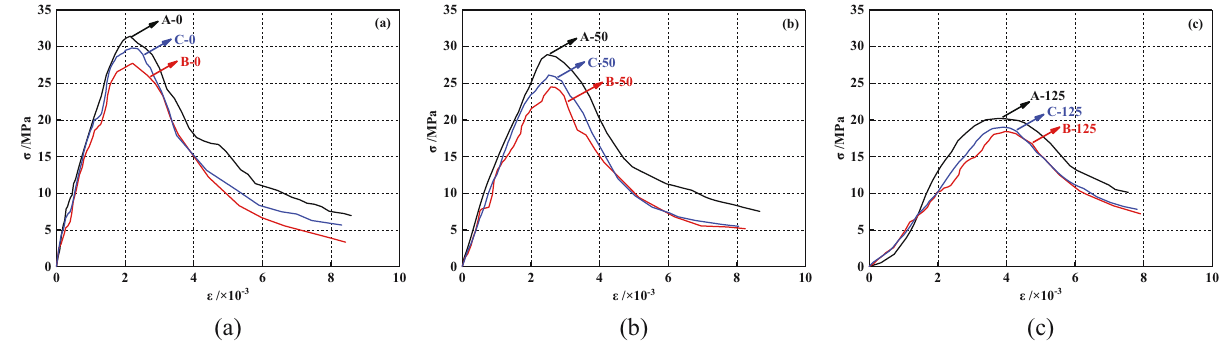
Figure 13: Comparison of stress – strain curves before and after freezing and thawing: ( a ) 0 time, ( b ) 50 time, and ( c ) 125 time.